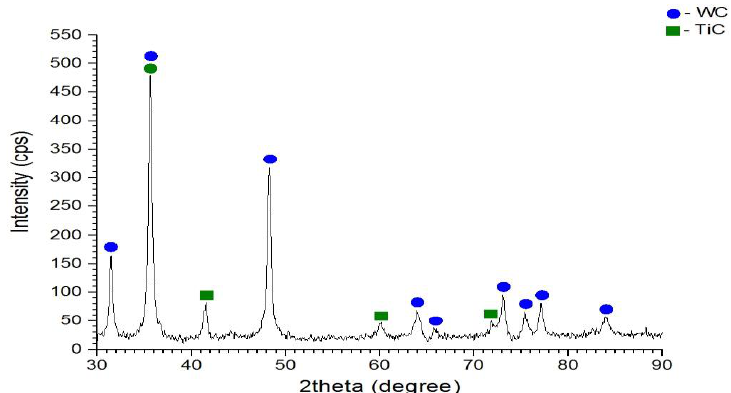
Figure 4. The representative XRD patterns of the MCT specimen.